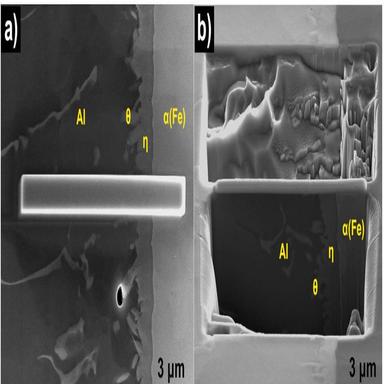
(a) SEM image obtained at the joint interface. (b) SEM image of the cross-section during the lift-out process.